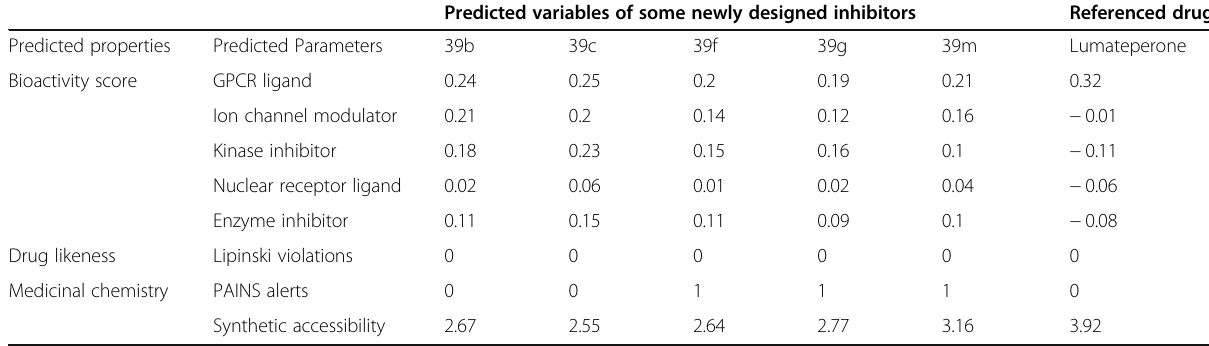
Table 4 Predicted bioactivity scores and medicinal chemistry of some designed inhibitors Predicted variables of some newly designed